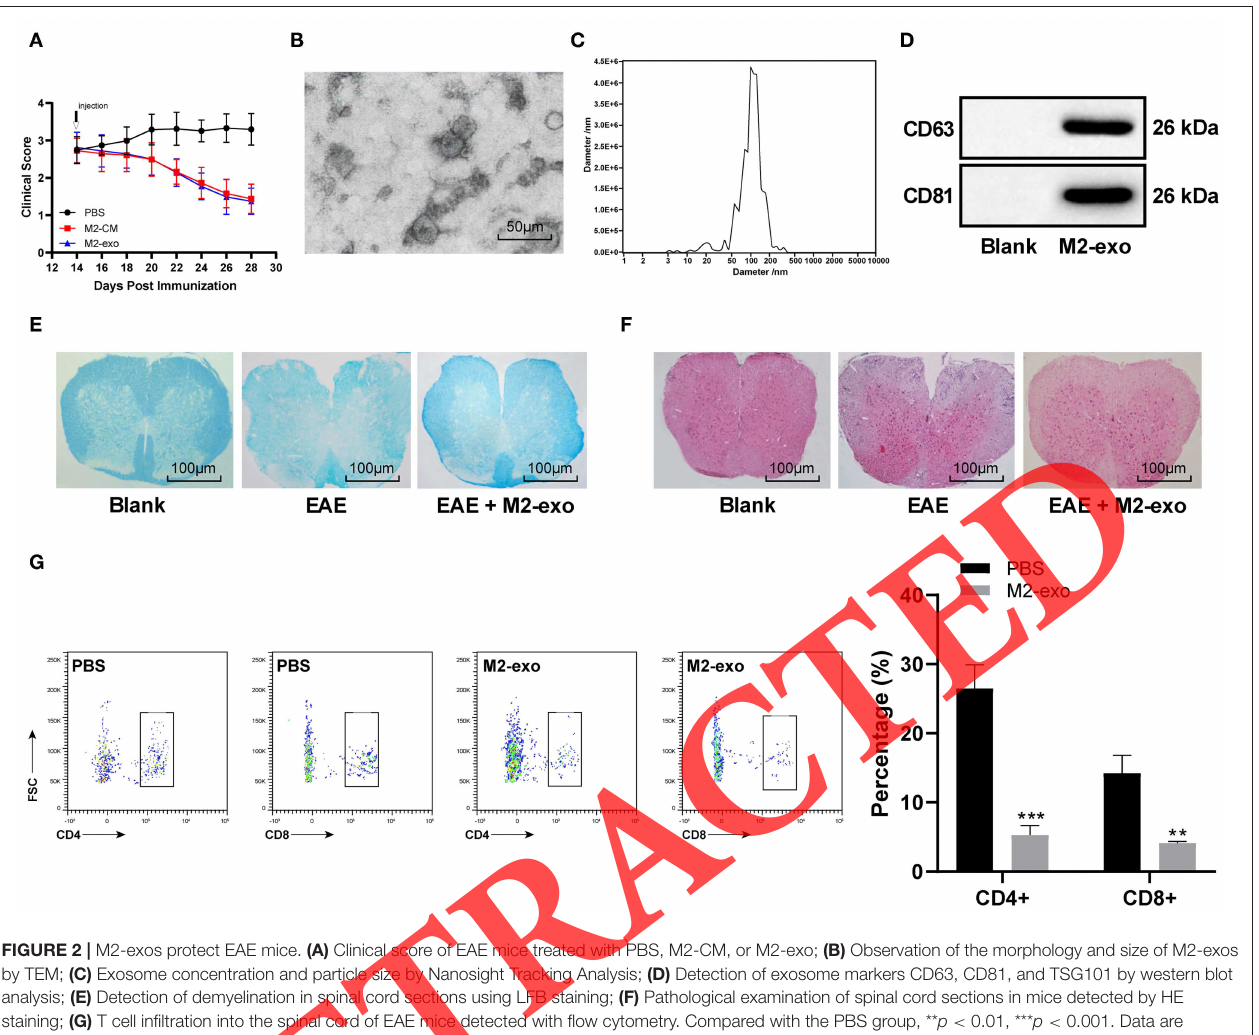
FIGURE 2 | M2-exos protect EAE mice. (A) Clinical score of EAE mice treated with PBS, M2-CM, or M2-exo; (B) Observation of the morphology and size of M2-exos by TEM; (C) Exosome concentration and particle size by Nanosight Tracking Analysis; (D) Detection of exosome markers CD63, CD81, and TSG101 by western blot analysis; (E) Detection of demyelination in spinal cord sections using LFB staining; (F) Pathological examination of spinal cord sections in mice detected by HE staining; (G) T cell infiltration into the spinal cord of EAE mice detected with flow cytometry. Compared with the PBS group, ** p < 0.01, *** p < 0.001. Data are analyzed with two-way ANOVA, and Tukey’s multiple comparisons test was utilized for post hoc test n =